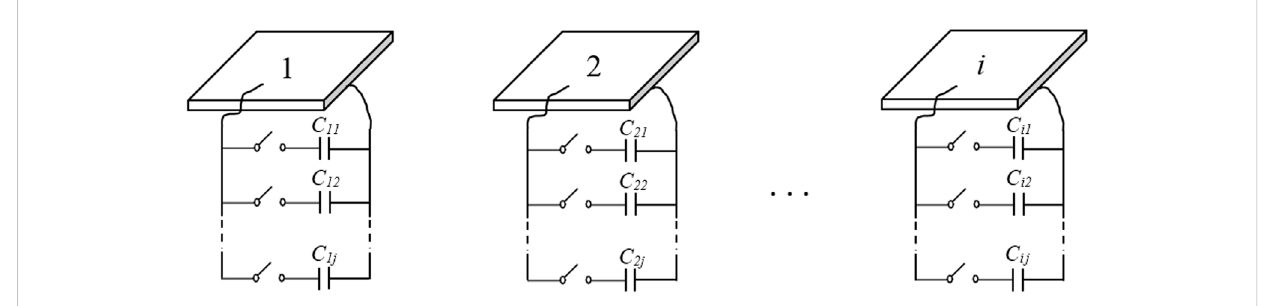
Capacitive shunts apply semi-active scheme applied to shunted piezoelectric